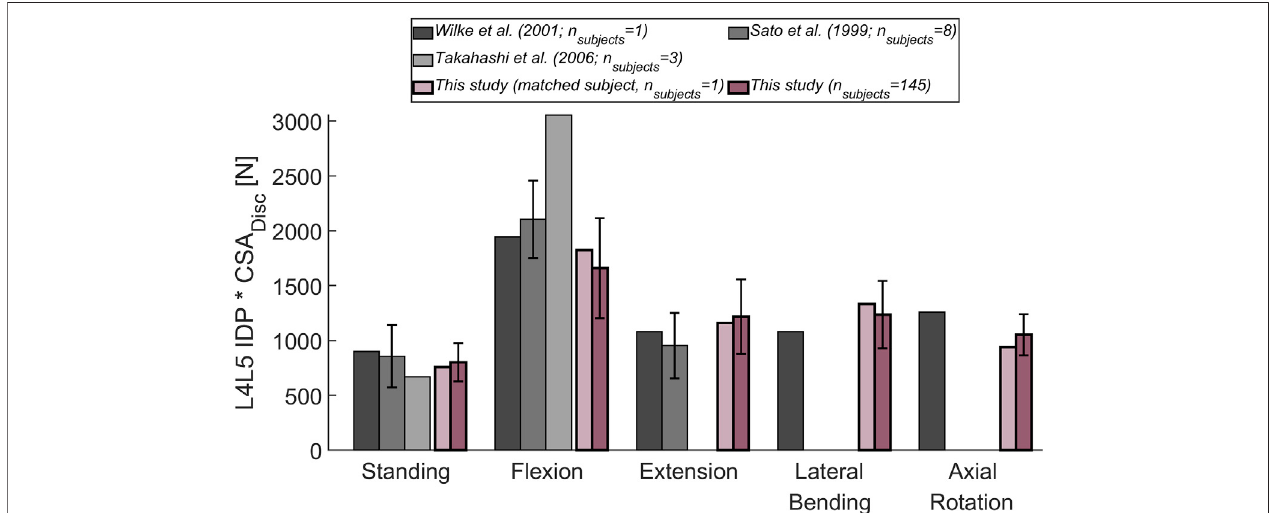
FIGURE 7| Comparison between measured (Wilke et al., 2001; Sato et al., 1999; Takahashi et al., 2006) and computed IDP at the L4L5 joint. The following upper body positions were simulated: standing, fl exion (30 ° ), extension (15 ° ),lateral bending (20 ° ),and axial rotation (30 ° ). To account for a varying CSA ofthe (mean) L4L5 IVD area in the different experimental studies, the experimentally determined IDP was multiplied by the respective CSA. The obtained results were compared to the mean results of the entire cohort considered in this study (dark purple). Additionally, the results for a subject (male, 34 years, 74 kg; light purple) with weight and age comparable to the subjects in the experimental studies, was depicted. Error bars indicate the standard deviation.